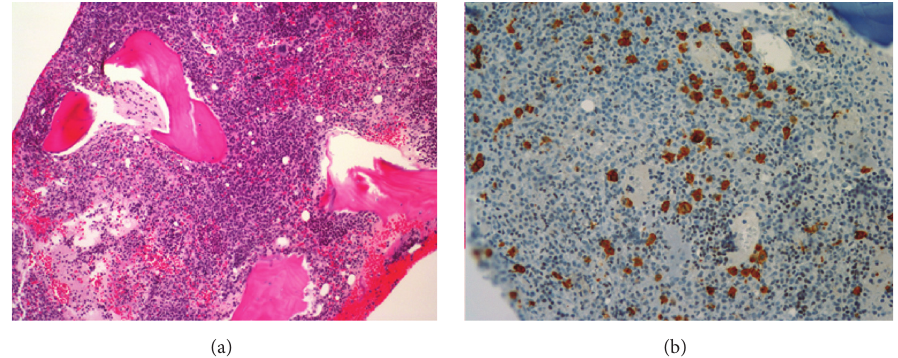
Figure 2: (a) Hypercellular bone marrow core biopsy demonstrating interstitial proliferation of large lymphoma cells. Hematoxylin and eosin stained bone marrow core biopsy ( × 100). (b) CD30 immunohistochemical stain of the bone marrow core biopsy. A subset of the large lymphoma cells are CD30 positive. Ber-H2 antibody ( ×